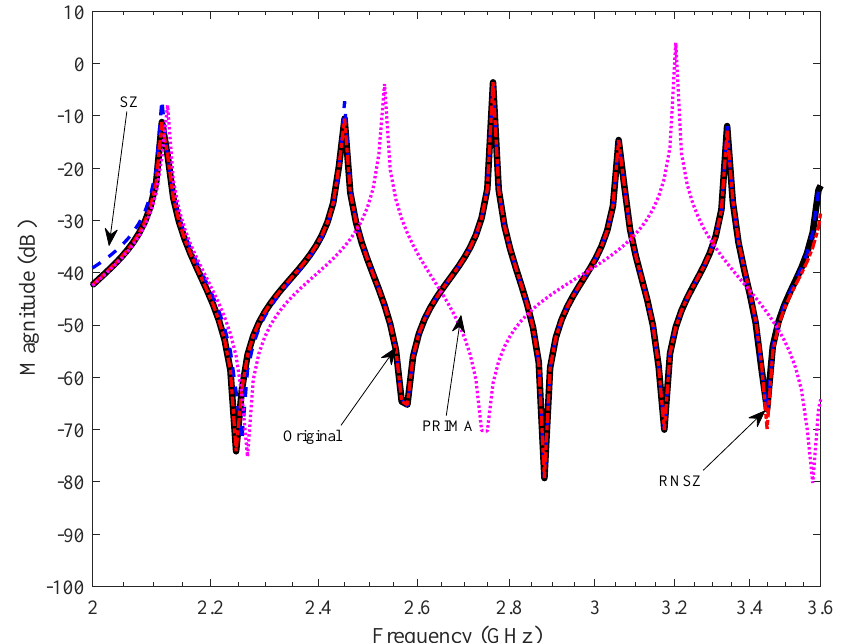
Figure 6. Magnitude response of RLC network for a large span of frequency (2 GHz to 3.5 GHz). The complexity of the reduce order model increased from N = 10 to 20.